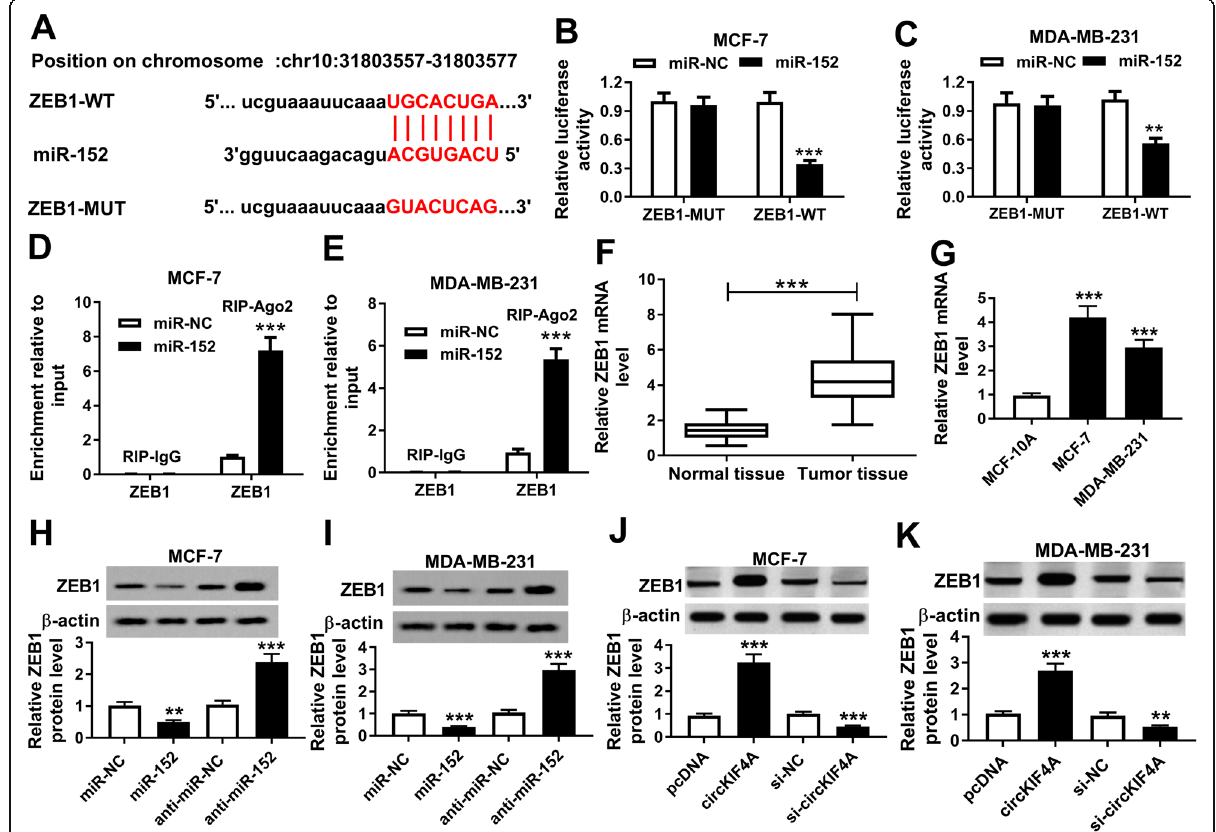
Fig. 4 CircKIF4A regulated ZEB1 expression by targeting miR-152. ( a ) The predicted binding sites between miR-152 and 3 ′ UTR of ZEB1. ( b and c ) The luciferase activity was detected in MCF-7 and MDA-MB-231 cells transfected with ZEB1 3 ′ UTR-WT or ZEB1 3 ′ UTR-MUT and miR-152 or miR- NC. ( d and e ) RIP assay was conducted, and the enrichment of ZEB1 was detected by qRT-PCR. ( f and g ) The mRNA level of ZEB1 in BC tissues and cells was determined via qRT-PCR. ( h and i ) The protein level of ZEB1 in BC cells treated with miR-152, anti-miR-152 or their controls was detected by western blot assay. ( j and k ) The protein level of ZEB1 in BC cells treated with circKIF4A, si-circKIF4A or their corresponding controls was detected by western blot assay. **P < 0.01, ***P <